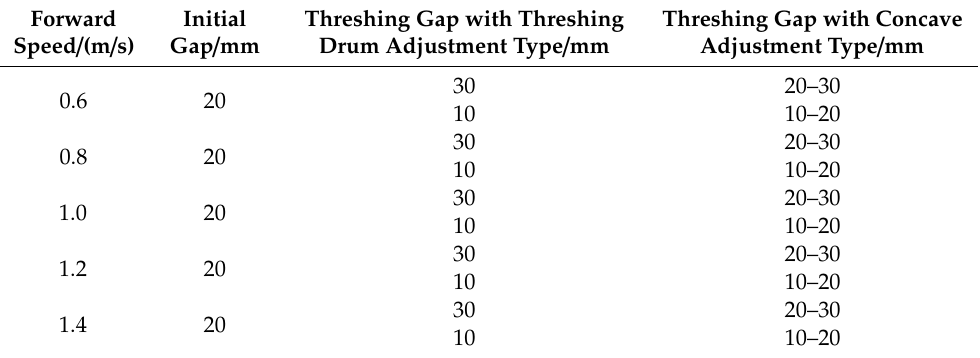
Table 1. Experiment